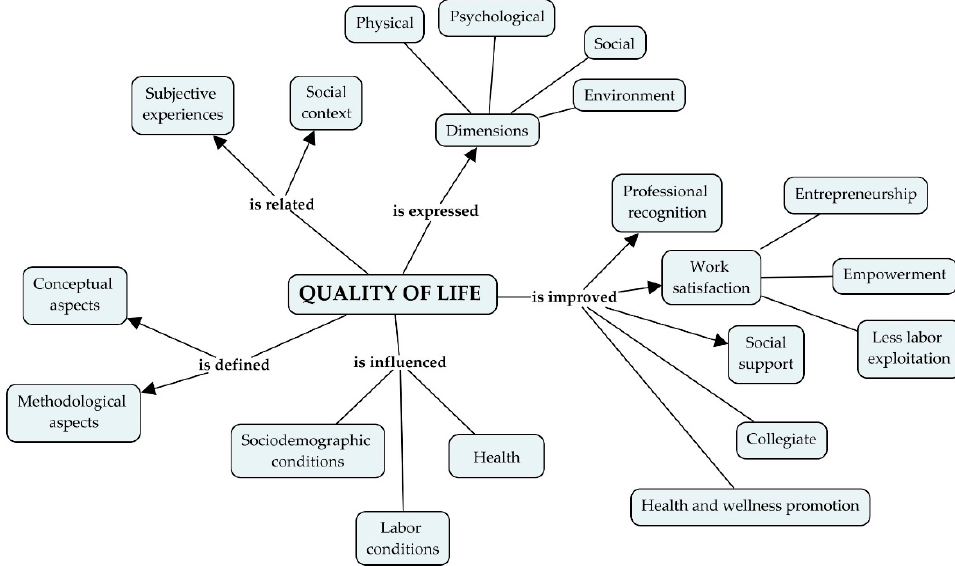
Figure 1. Explicative conceptual map for QOL and its determinants according to the triangulation of findings. Colombia, 2021–2022 ( n = 187). Elaborated by using Cmaptools 6.03.01.